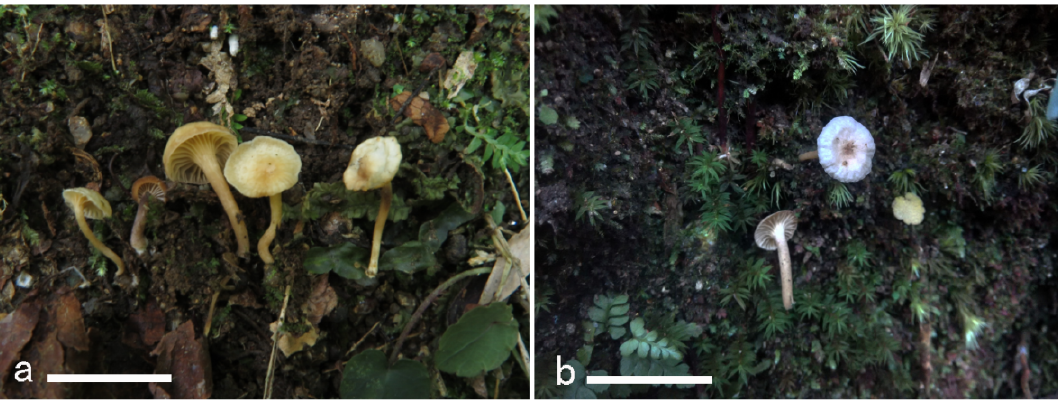
Figure 12. Basidiomata of Cantharellus convexus. ( a ) GDGM70307. ( b ) GDGM54841. Bars = 2 cm.